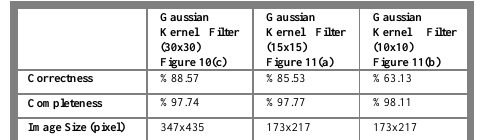
Table 4: Evaluation of Different Size of Gaussian Kernel Filter for image in figure 10(c) and down sampled version in figure 11 Gaussian Kernel Filter (30x30)